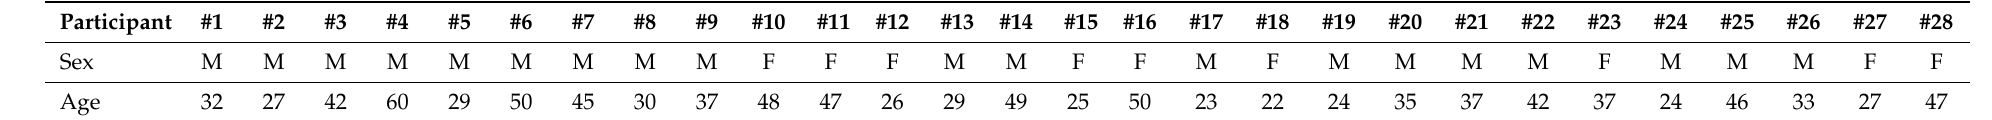
Table 1. Participants characteristics (F—female;